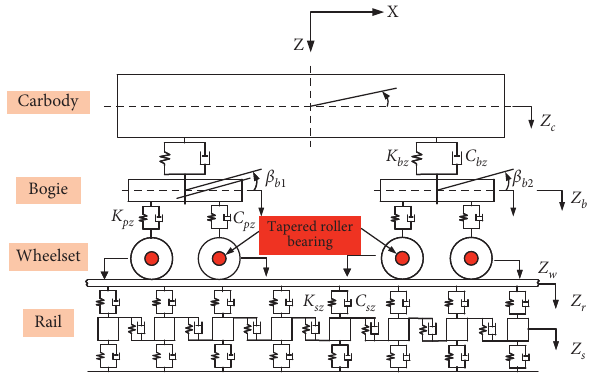
Figure 1: Vertical vehicle-track coupled dynamics model.